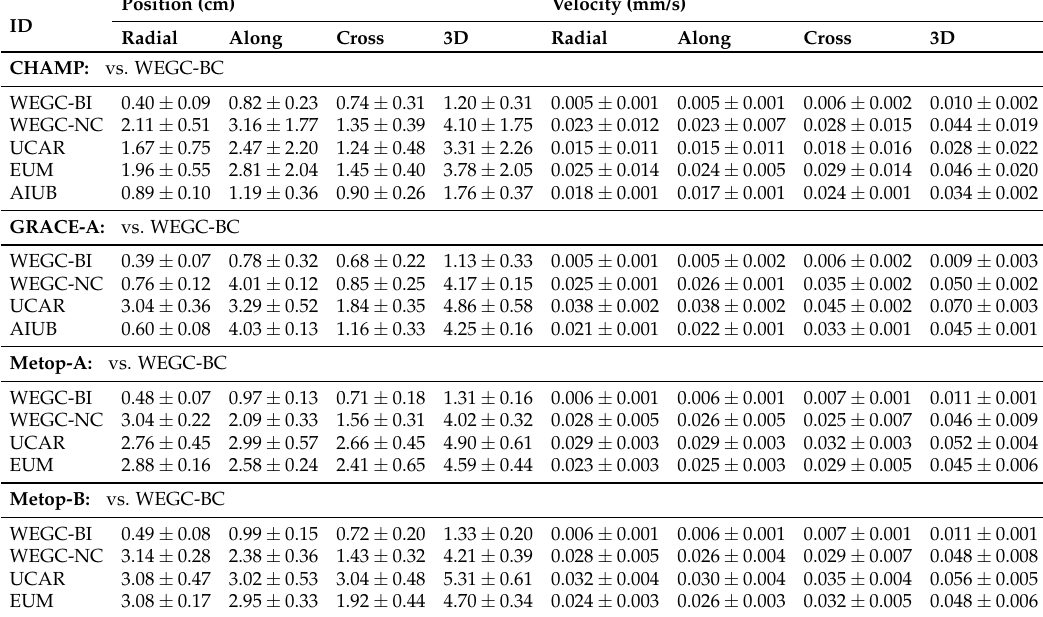
Table 3. Orbit comparison for position and velocity in radial, along-track, cross-track, and corresponding 3D-RMS for different orbit solutions compared to WEGC-Bernese primary precise orbit determination solution listed for CHAMP and GRACE-A (Jun/Jul/Aug 2008) and Metop-A/B (Jun/Jul/Aug 2013). Days exceeding 20 cm in 3D-RMS (10 days) have been disregarded in the statistics. Position (cm) Velocity (mm/s) ID Radial Along Cross 3D Radial Along Cross